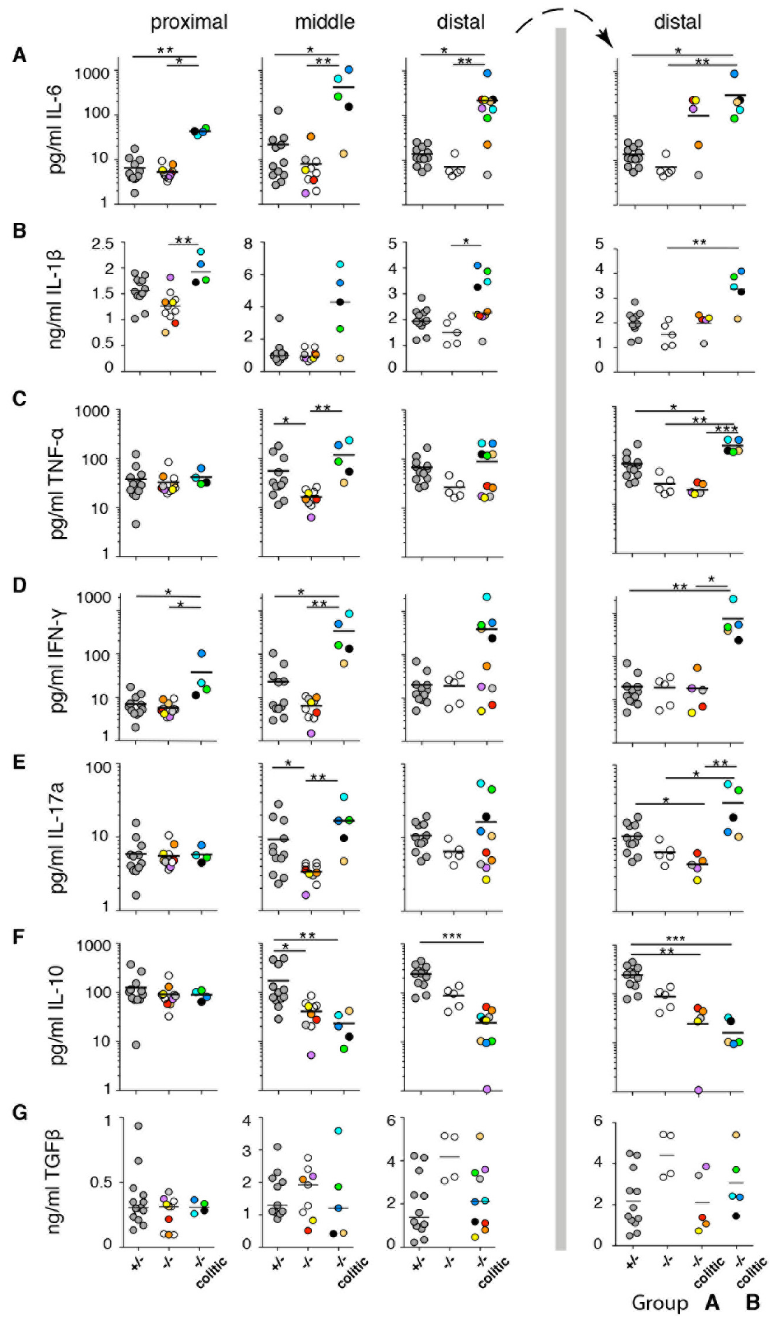
Fig 3. Inflammatory cytokines characterize the distal colon of a subgroup of colitic Muc2 -/- mice. Saponin extracts of proximal, middle and distal colon were prepared and normalized to total protein concentration. Cytokine expression was analyzed by CBA (A, C- F) or ELISA (B, G). Each symbol represents an individual mouse and the solid line indicates the mean of each group. Symbols of the same color in Figs 3 and 4 and S1 Fig represent samples from the same colon segment of the same animal. Mice are segregated into colitic and non-colitic according to neutrophil influx into the colon LP in the respective colon segment. Data are pooled from 5 independent experiments that examined 27 mice. The distal colon panels to the right of the vertical bar show the same distal colon data as to the left of the bar except that the colitic mouse group is segregated into group “ A ” and “ B ” . Statistical significance between groups was assessed using the Kruskal-Wallis test followed by Dunn ’ s multiple comparison test.